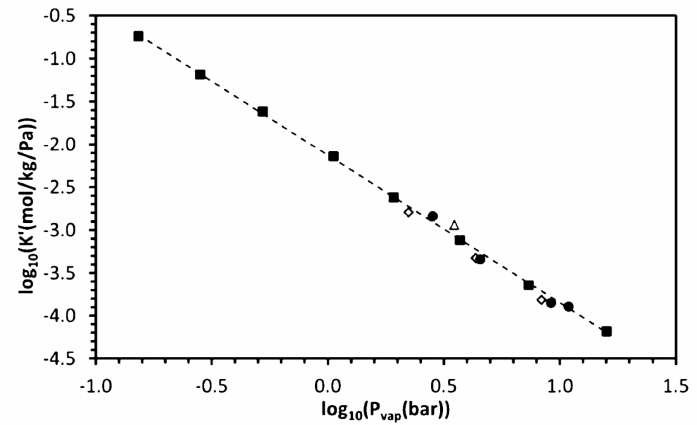
Figure 14. Logarithm of Henry constants as a function of the logarithm of the vapor pressure at 423 K for linear ( (cid:4) ), monomethylbranched ( ), dimethylbranched ( • ), and trimethylbranched ( ∆ ) alkanes (cid:51) on ZIF-68. Reprinted with permission from [72]. Copyright (2015) American Chemical